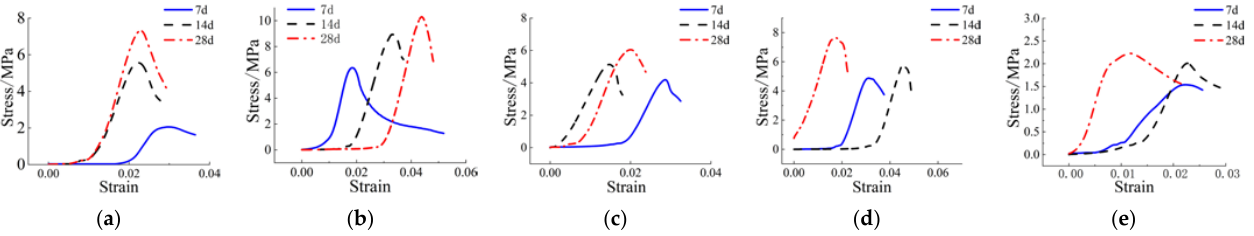
Figure 6. Stress–strain curves of test blocks at different ages. ( a ) Group G; ( b ) Group H; ( c ) Group I; ( d ) Group J; ( e ) Group K.